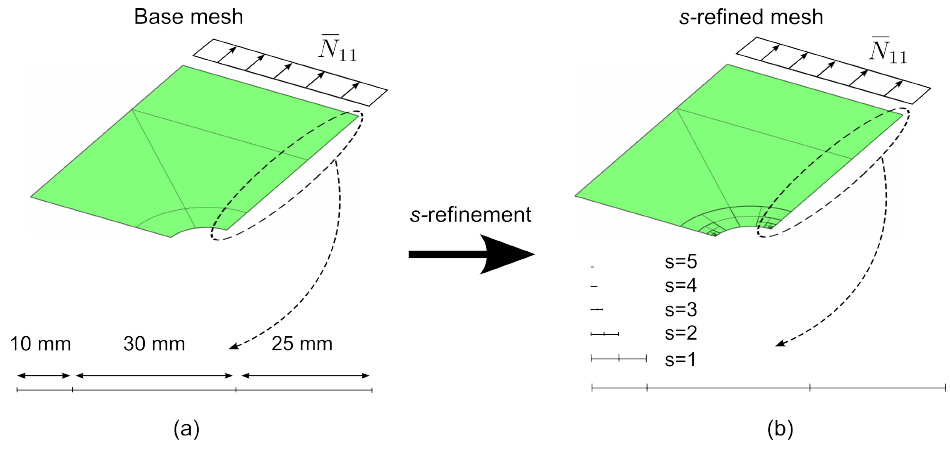
Figure 13. Plate with cutout — static analysis: ( a ) Base mesh, ( b ) s − refined